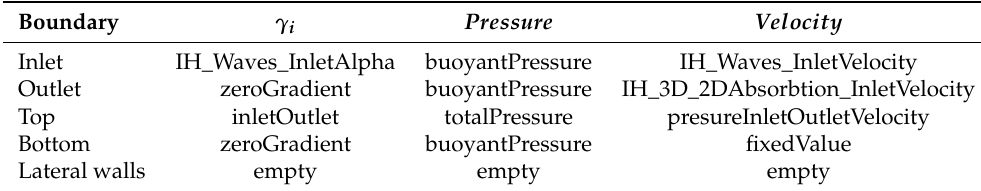
Table 3. Boundary condition for the NWT in IHFOAM